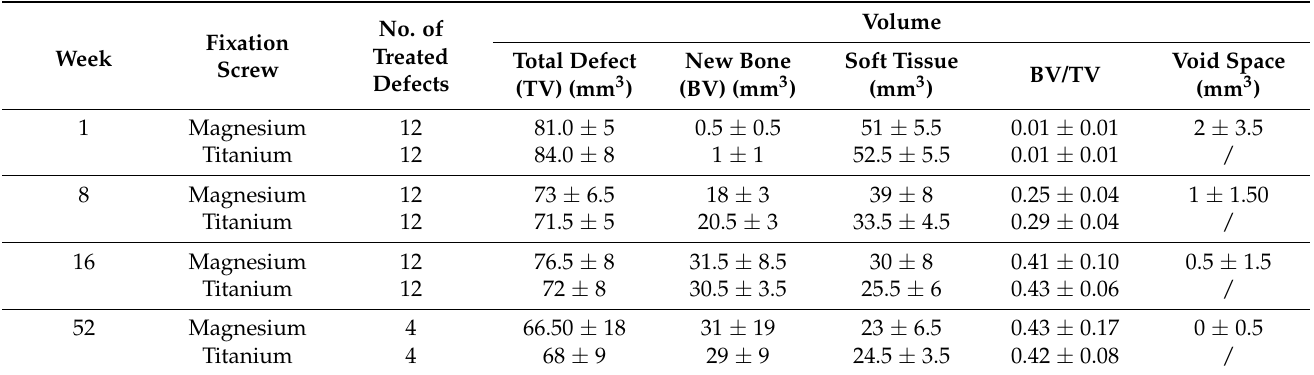
Table 1. µ CT volume measurements for treated GBR defects covered with a collagen barrier mem- brane that is fixated with either magnesium or titanium fixation screws.